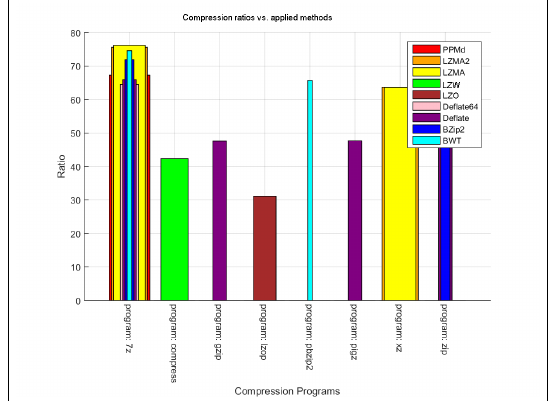
Figure 3: Graph of average compression ratio of each applied